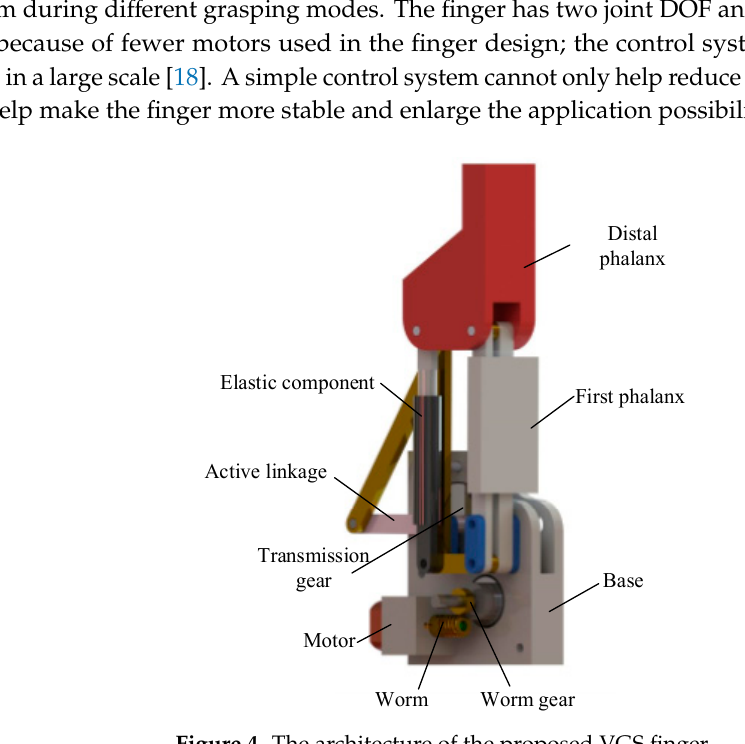
C dD Figure 5. Kinematic model of the VGS finger mechanism.